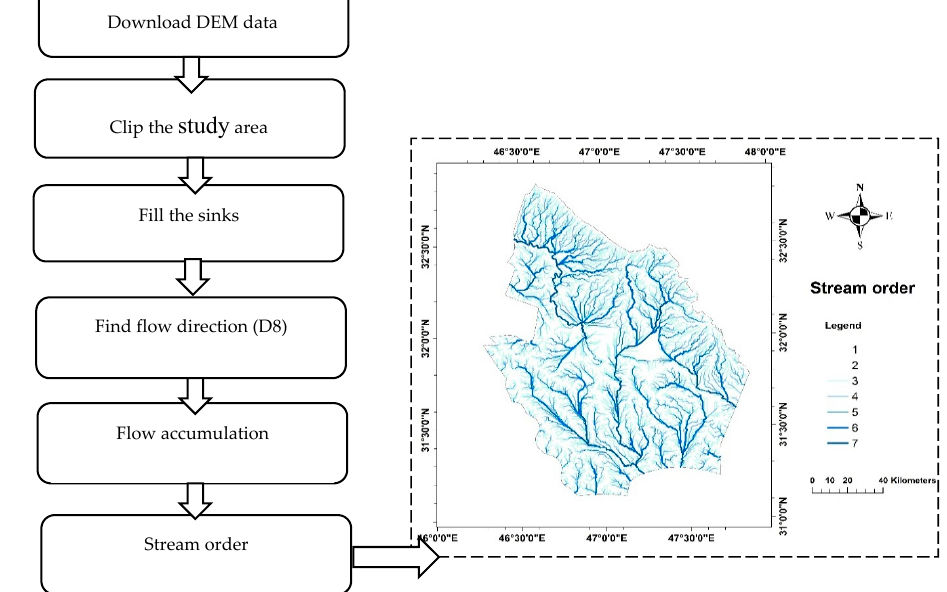
Figure 3. Main steps to derive the stream order based on DEM.